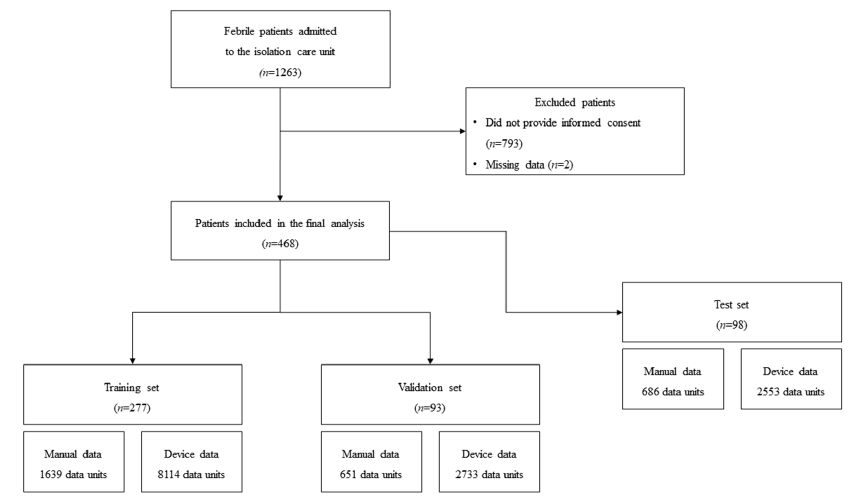
Figure 2 . Flowchart of patient selection for the study . Figure 2. Flowchart of patient selection for the study.